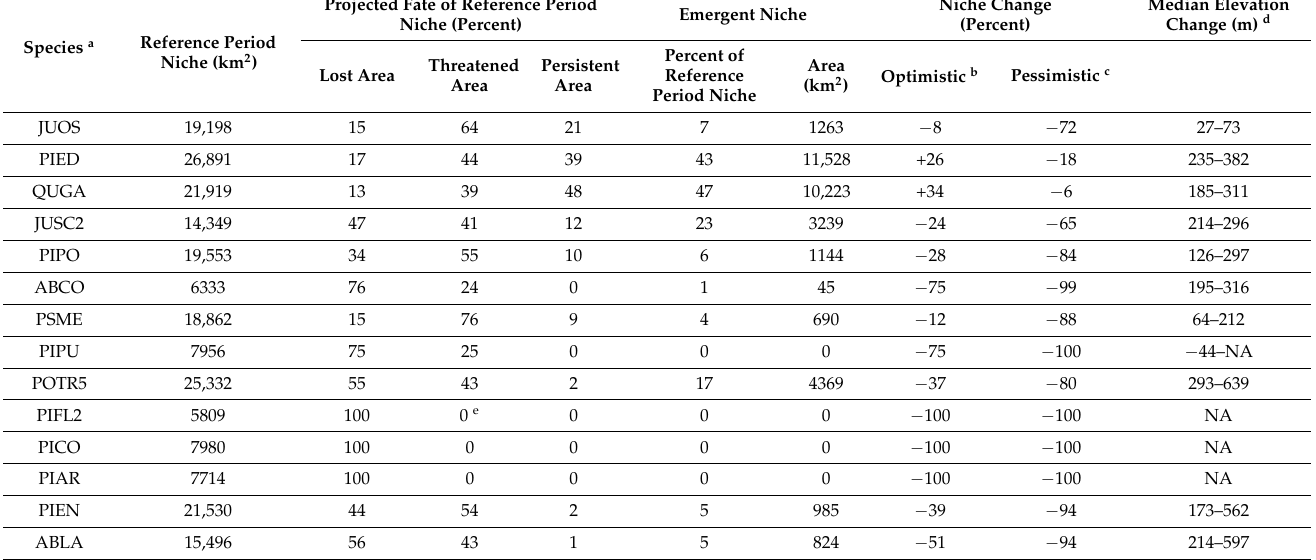
a Sorted by median elevation in the reference period (Table 1). b Assuming survival of trees in threatened class. c Assuming mortality of trees in threatened class. d Elevation change under optimistic to pessimistic assumptions. e Fifty-three cells of PIFL2 (6 × 10 − 5 percent of reference area) are